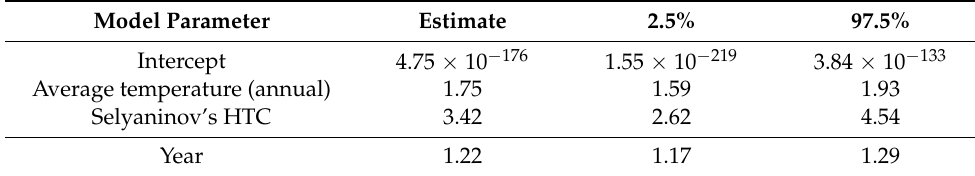
Table 2. Estimates and confidence interval for predictor variables in negative binomial regression model with number of tick bite cases as response variable. All included parameters are significant at p < 0.01. All values are exponentiated to reflect true response. Model